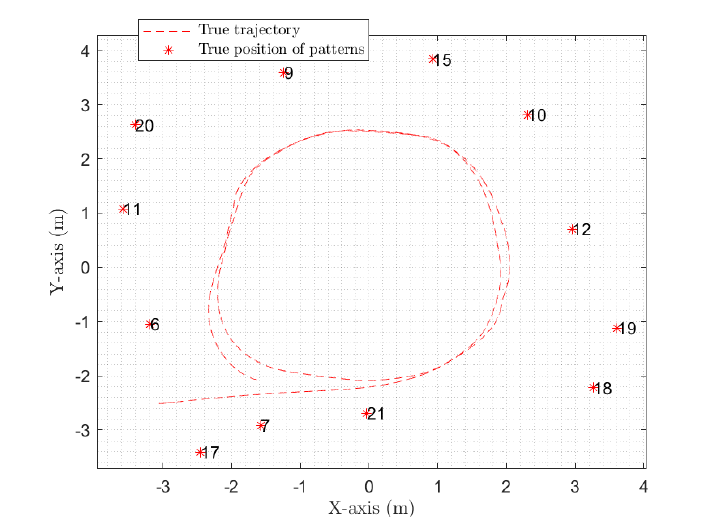
Figure 7. First image frame integrated in the detector: it computes the ellipse coordinates of the pattern with labels 18, 19, and 21.